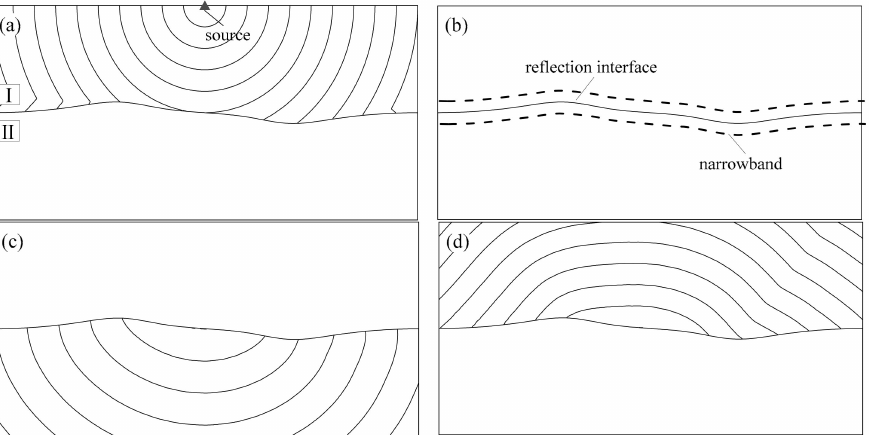
Figure 9. The process of multistage approach. ( a ) The down-going wavefront from the source to the reflection interface, ( b ) the narrowband at the reflection interface, ( c ) the transmitted wavefront and ( d ) the reflected wavefront from the narrowband in Figure 9b. The gray triangle (cid:78) represents the source, the solid curve in the middle represents the reflection interface, the dotted curves in Figure 9b represent the narrowband of FMM at the reflection interface and other solid curves in Figure 9a,c,d represent the wavefronts. Region I is above the interface and Region II is below the interface.